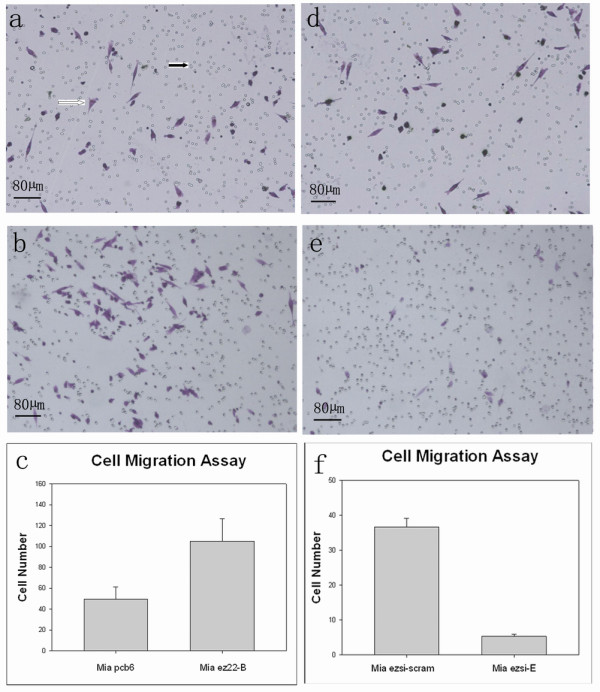
Effects of ezrin on cell motility in vitro. BioCoat Chambers were used to detect cell migration and representative fields were photographed. Black-arrows indicate the 8-µm membrane pores, and hollow-arrows indicate cells that had migrated through the membrane, which were stained with Crystal Violet (a). Cell migration of the Mia ez22 (b), Mia pcb6 (a), Mia ezsi-E (e) and Mia ezsi-cram (d) cells after 12 hours were shown. The cells migrating to the lower chambers were analyzed. For quantification, the cells were counted in 10 random fields under a light microscope (×400). Compared to the Mia pcb6 cells, the Mia ez22-B cells showed a significant increase in migration by x2-test (c). The decrease in the numbers of migrated cells in the Mia ezsi-E cells compared to those of the Mia ezsi-scram cells was statistically significant, shown by the x2-test (f). Columns: mean; bars: SD.